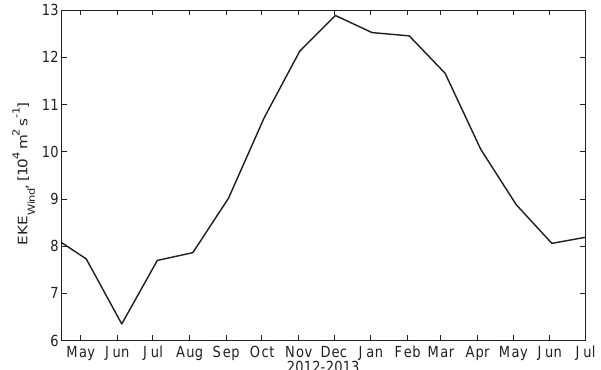
Figure 13. Time series of EKE in the 2–6-day band from wind ob- servations in Torshavn (Cappelen, 2014) during 2012–2013.